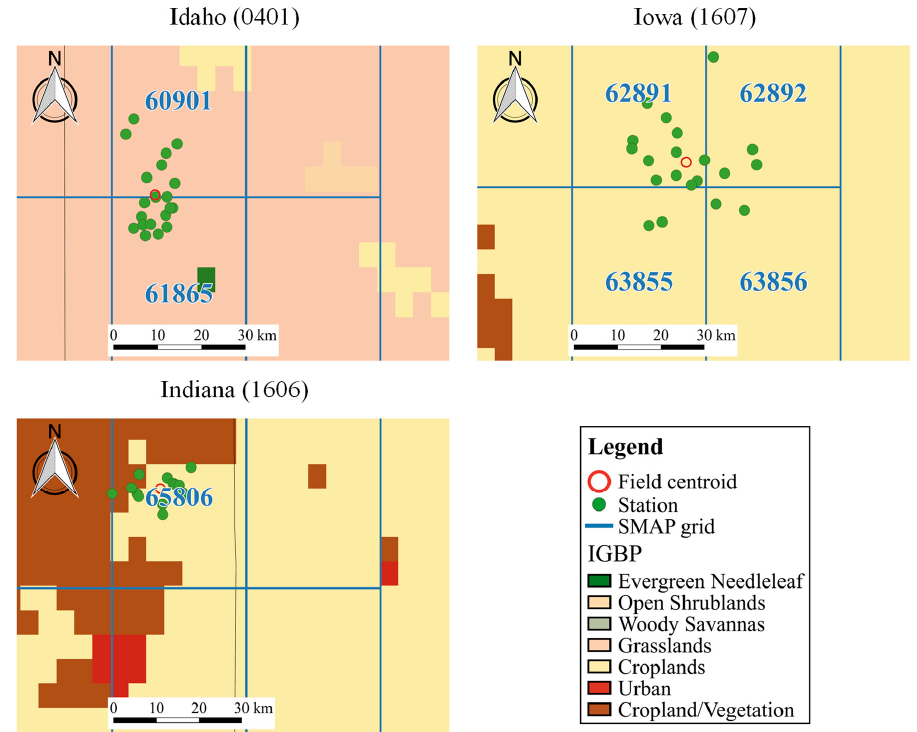
Figure 2. SMAP grids (blue), in situ stations (green), and station centroid (red) for the Idaho, Iowa, and Indiana SMAP CVSs. The background is the same as in Figure 1.